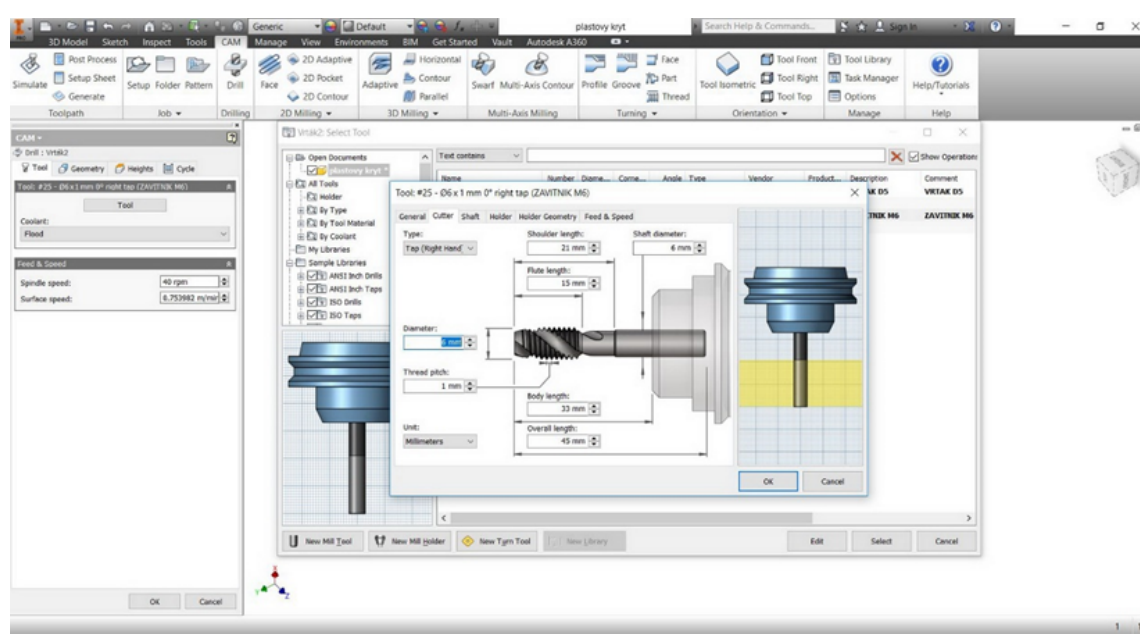
Figure 10: Selection of taps and cutting conditions for the M6 hole.